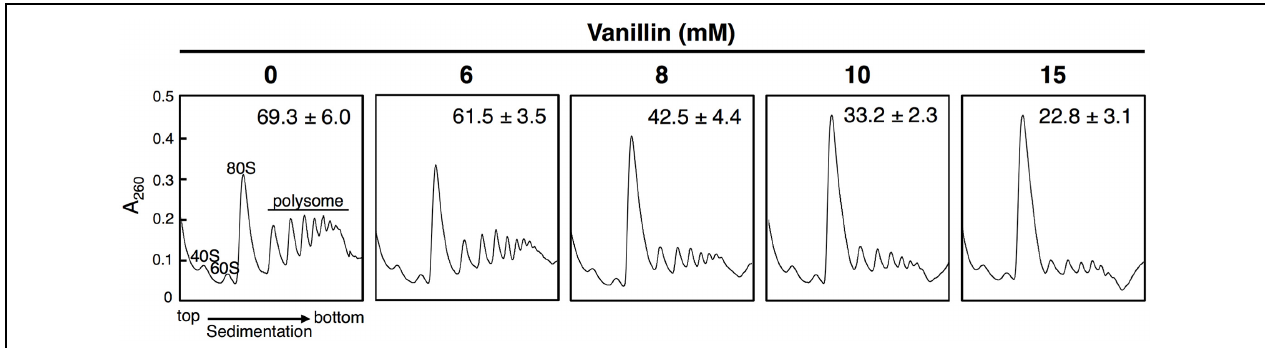
FIGURE 1 | High concentrations of vanillin inhibit translation initiation in Saccharomyces cerevisiae BY4742. Cells in an exponential phase of growth in SD medium were treated with vanillin (6–15 mM) for 30 min. The polysome profile of cells treated with vanillin was determined. The polysome, 40S (small ribosomal subunit), 60S (large ribosomal subunit), and 80S (monosome) peaks are labeled. The numbers in the panels indicate the percentages of polysomal ribosomes. Data are represented as the mean ± SD of three independent experiments.